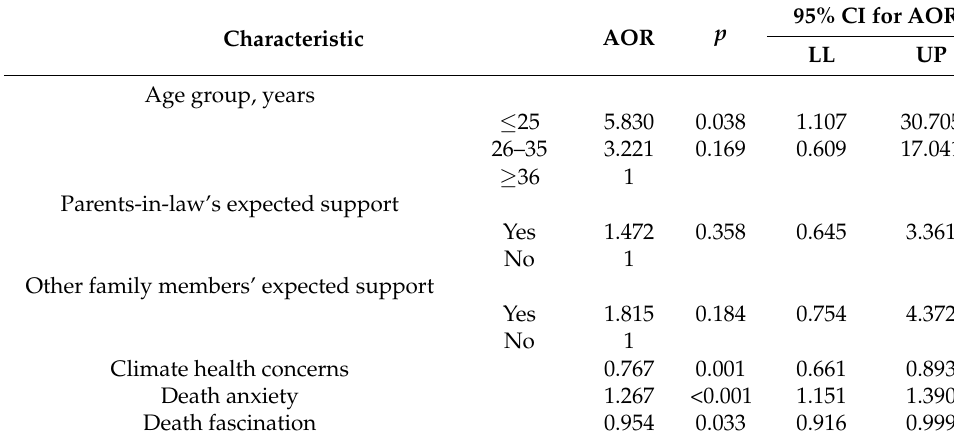
Table 5. Multi-factor logistic regression model predicting positive reproductive intention (N =